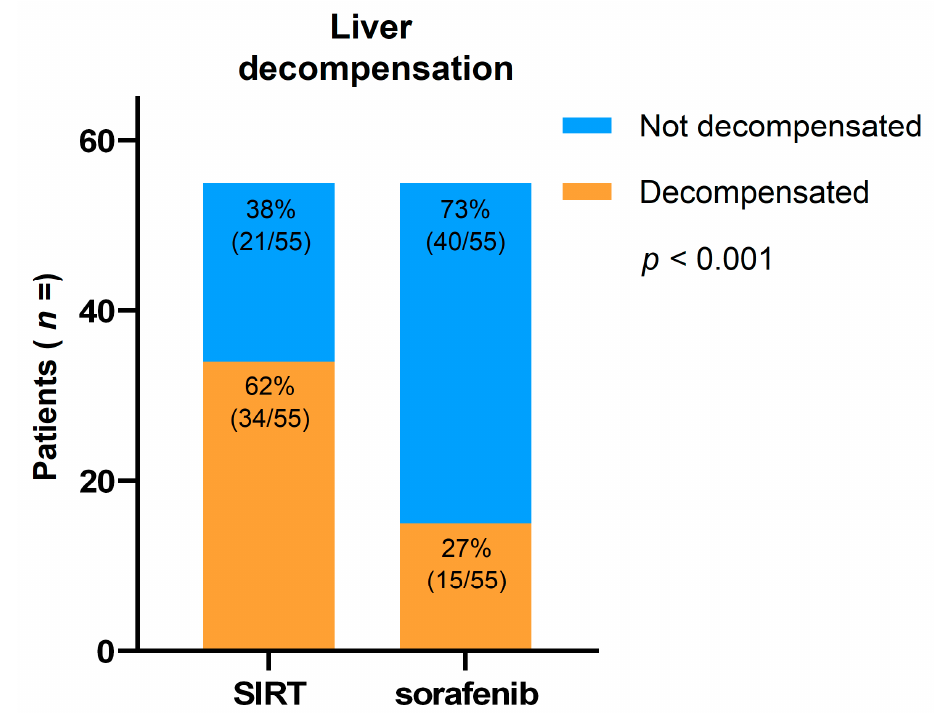
Figure 5. Number of patients with liver decompensation at last follow-up, where SIRT is compared with a matched cohort of patients treated with sorafenib.